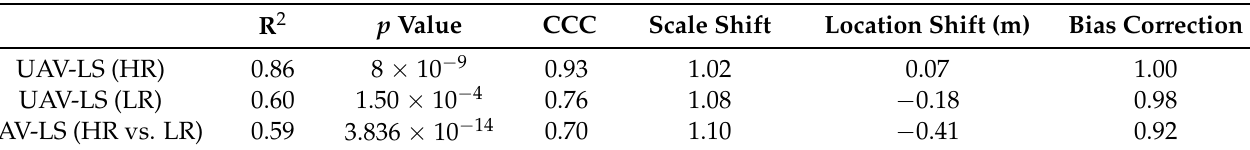
Table 5. Linear regressions and CCC of the height estimations using the grid approach. For the top 2 rows, the benchmark data set is used as validation.